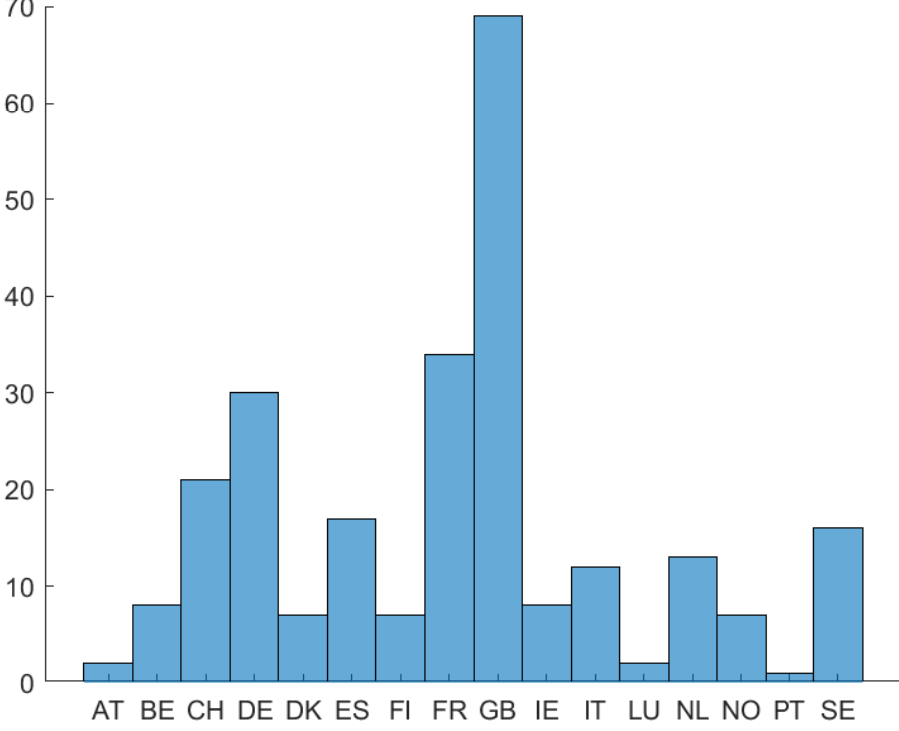
Figure 1. The number of firms in each country in our dataset. Source: Authors’